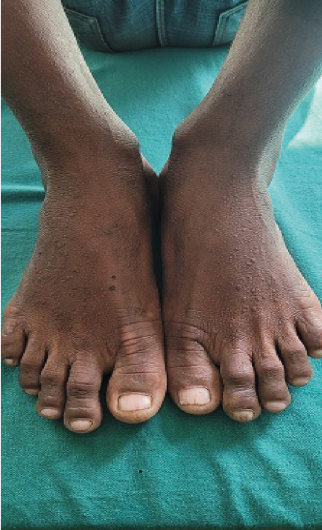
Figure 3: Multiple keratotic papules over the dorsum of the